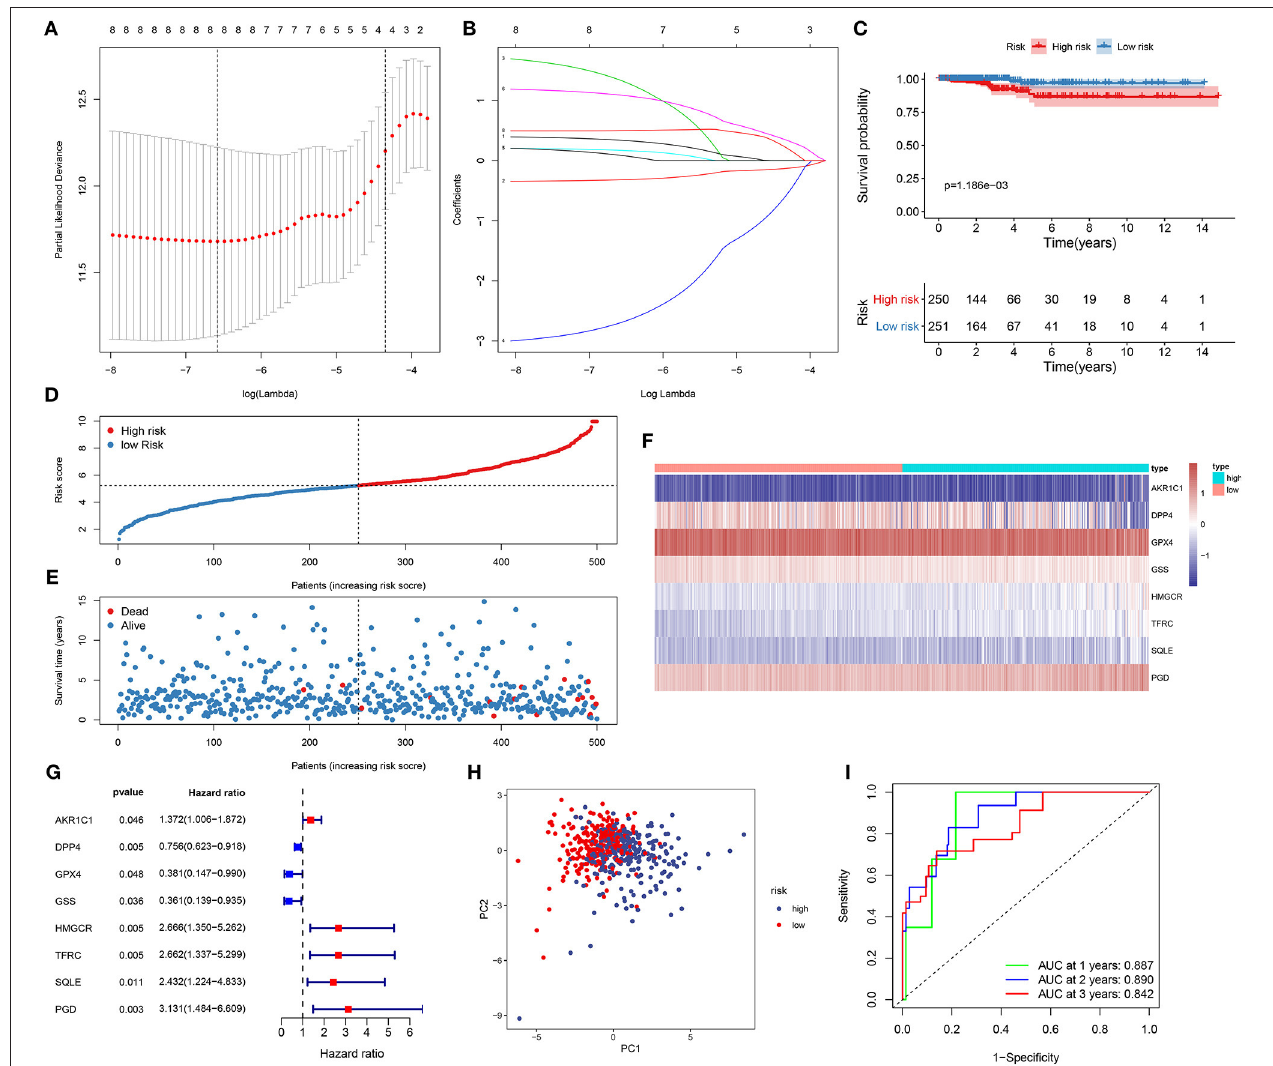
FIGURE 1 | Establishment of a ferroptosis-related eight-gene model for predicting the prognosis of thyroid cancer patients. (A) Selection of the optimal λ -value through the 10-fold cross-validation. (B) Fitting processes of LASSO Cox regression model. Each curve is indicative of the change trajectory of an independent variable coefficient. The ordinate is the value of the coefficient, the lower abscissa is log( λ ), and the upper abscissa is the number of non-zero coefficients in the model. (C) Kaplan-Meier overall survival analysis for high (red) and low (blue) risk groups. (D) The ranking of the risk scores among all thyroid cancer samples. (E) The survival status including dead (red) and alive (blue) in high and low risk groups. (F) Heat map visualizing the expression levels of the eight ferroptosis-related genes in high (blue) and low (red) risk groups. (G) The prognostic values of the eight ferroptosis-related genes for thyroid cancer based on univariate cox regression analysis. (H) PCA for the high (blue) and low (red) risk thyroid cancer samples. (I) ROC for 1- (green), 2- (blue) and 3-year (red) survival time for high and low risk